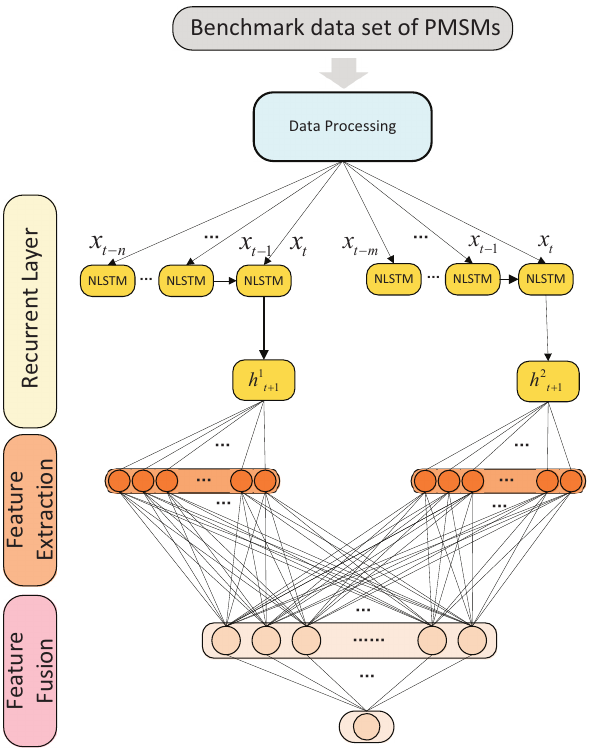
Figure 3. The architecture of PSNLSTM. Where x t − m , · · · x t − n , · · · x n are one-dimensional tensors as inputs, n < m . h 1 is the higher level temperature characteristics obtained by NLSTM network with t + 1 short time steps, h 2 is the higher level temperature characteristics obtained by NLSTM network t + 1 with long time steps, and these are also one-dimensional